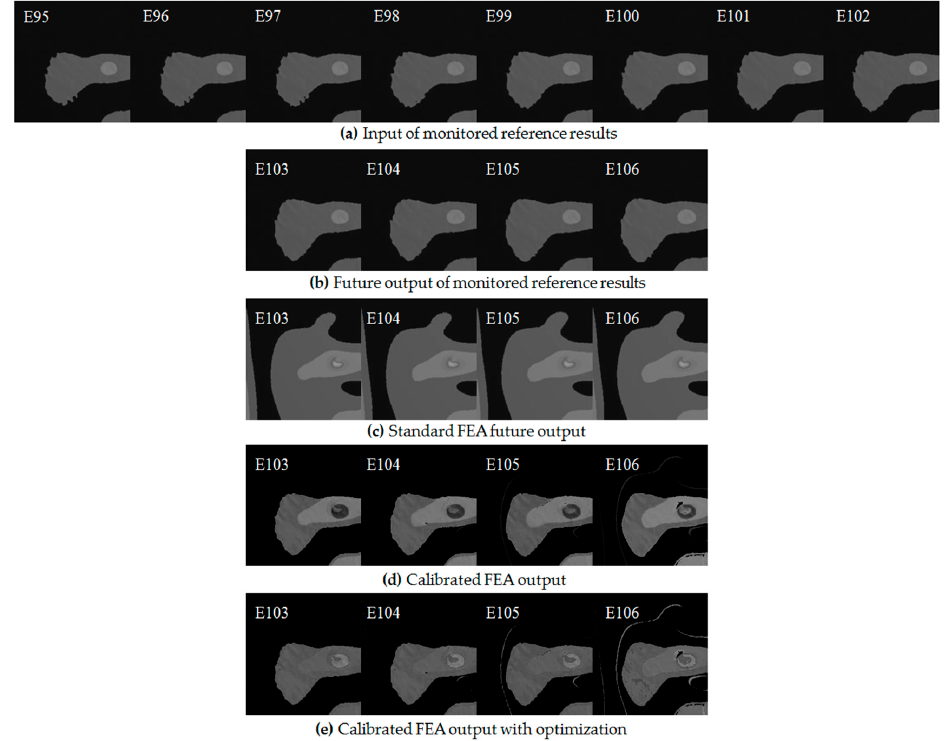
Figure 9. Calibrated FEA results.